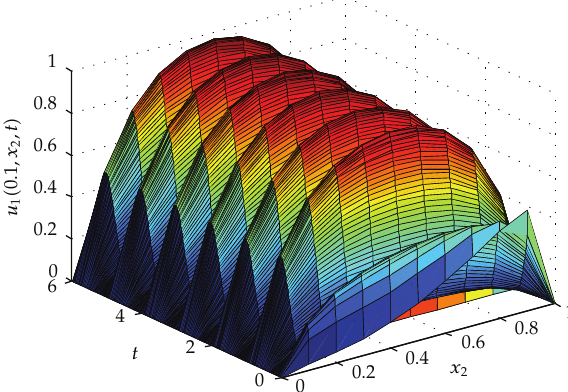
Figure 3: The surface of u 1 (cid:3) t, 0 . 1 ,x 2 (cid:4) when x 1 (cid:8) 0 .